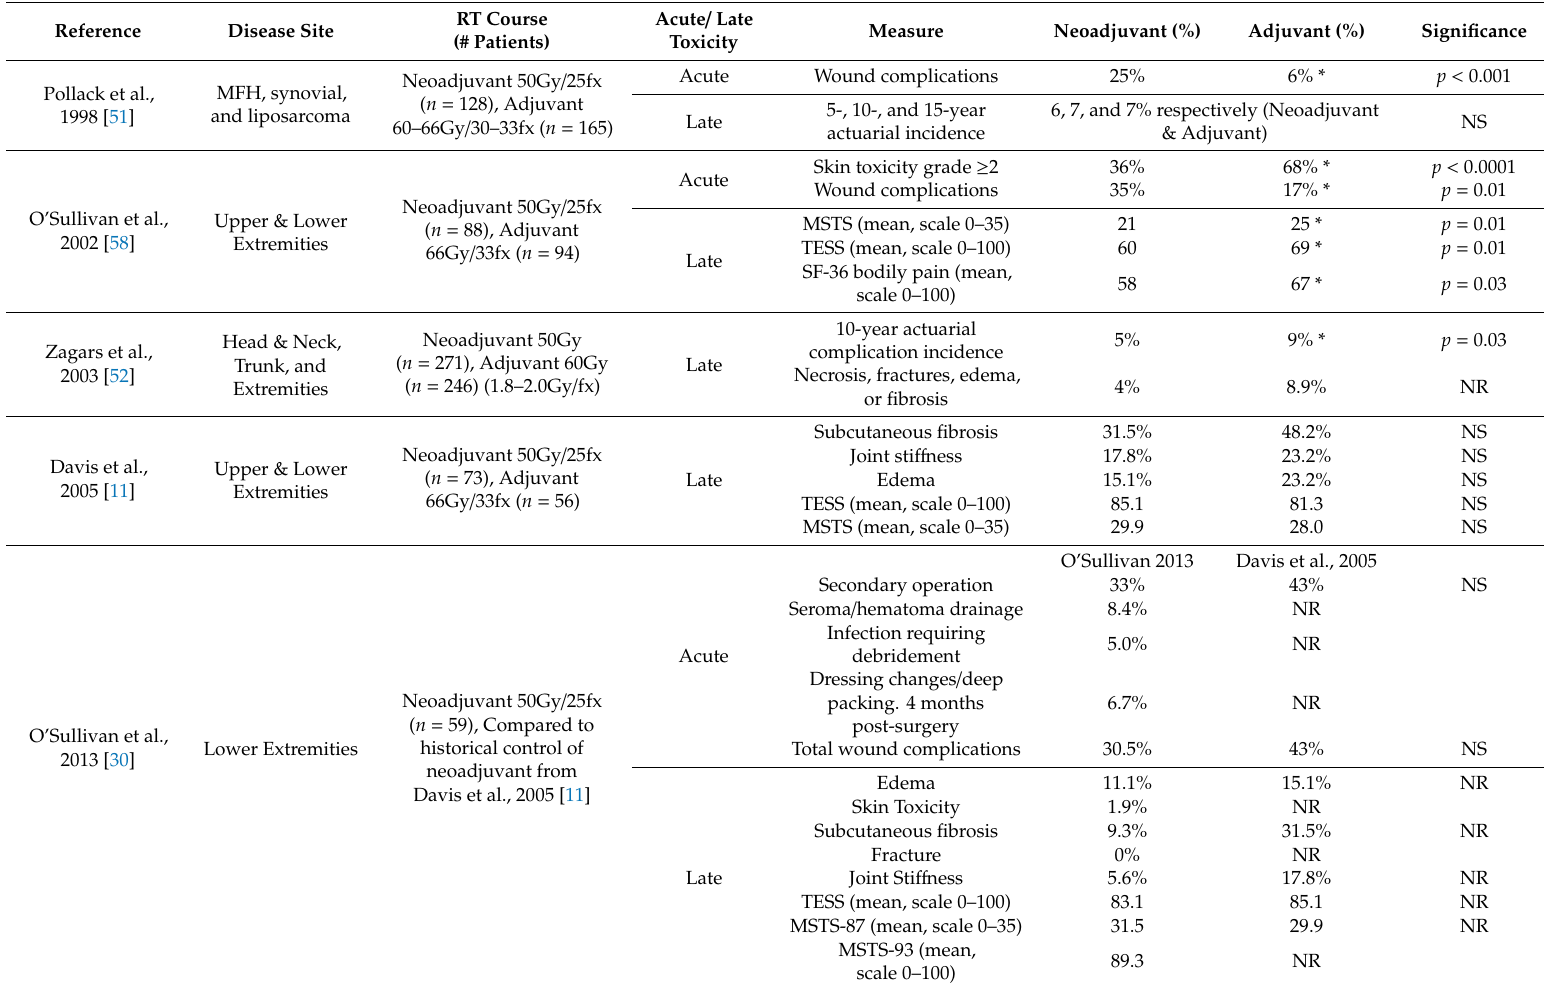
Table 1. Comparison of neoadjuvant vs. adjuvant acute and late wound complication in soft tissue